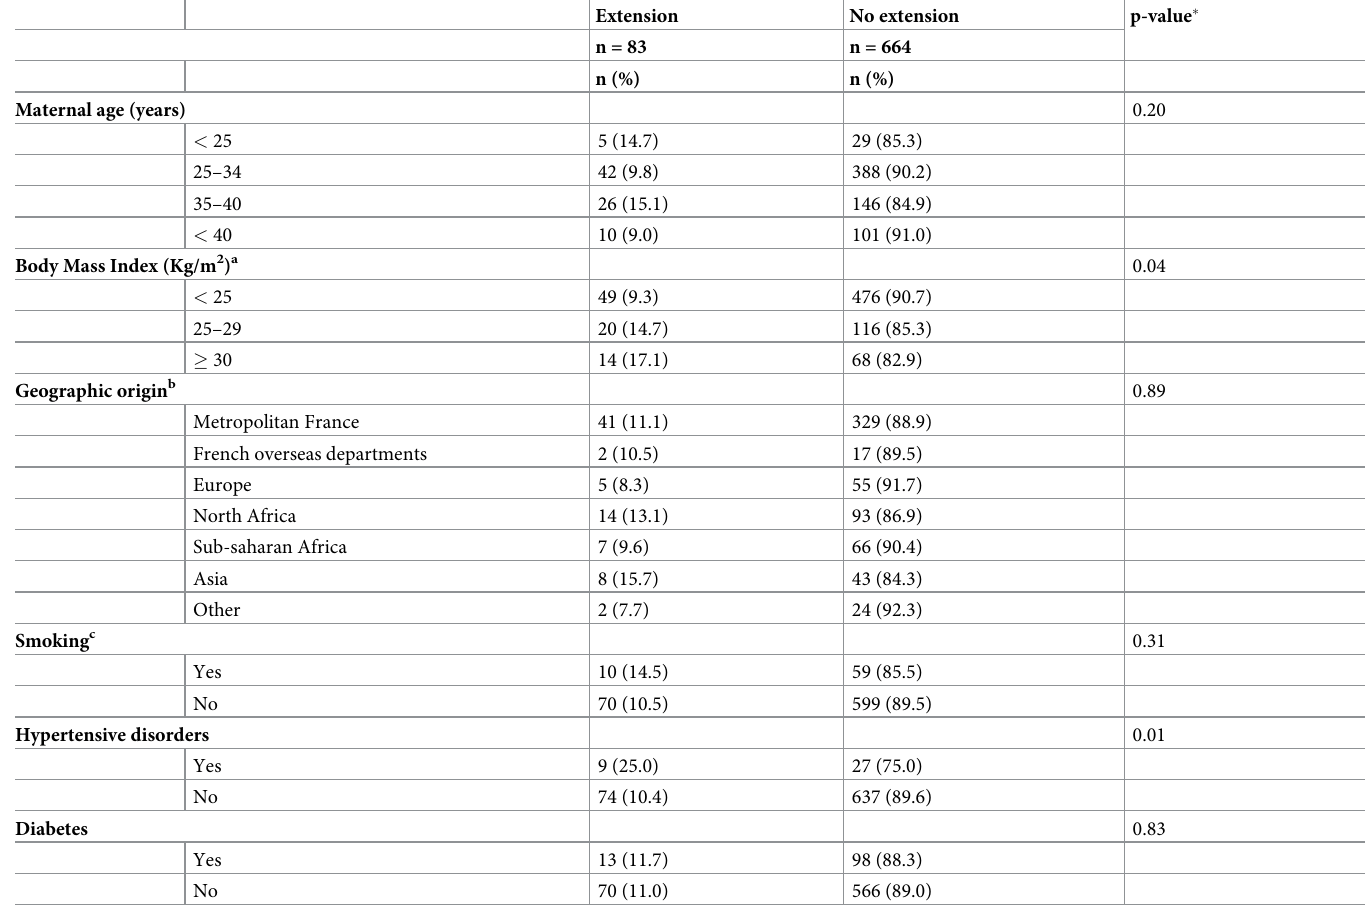
Table 1. Frequency of incision extensions according to maternal